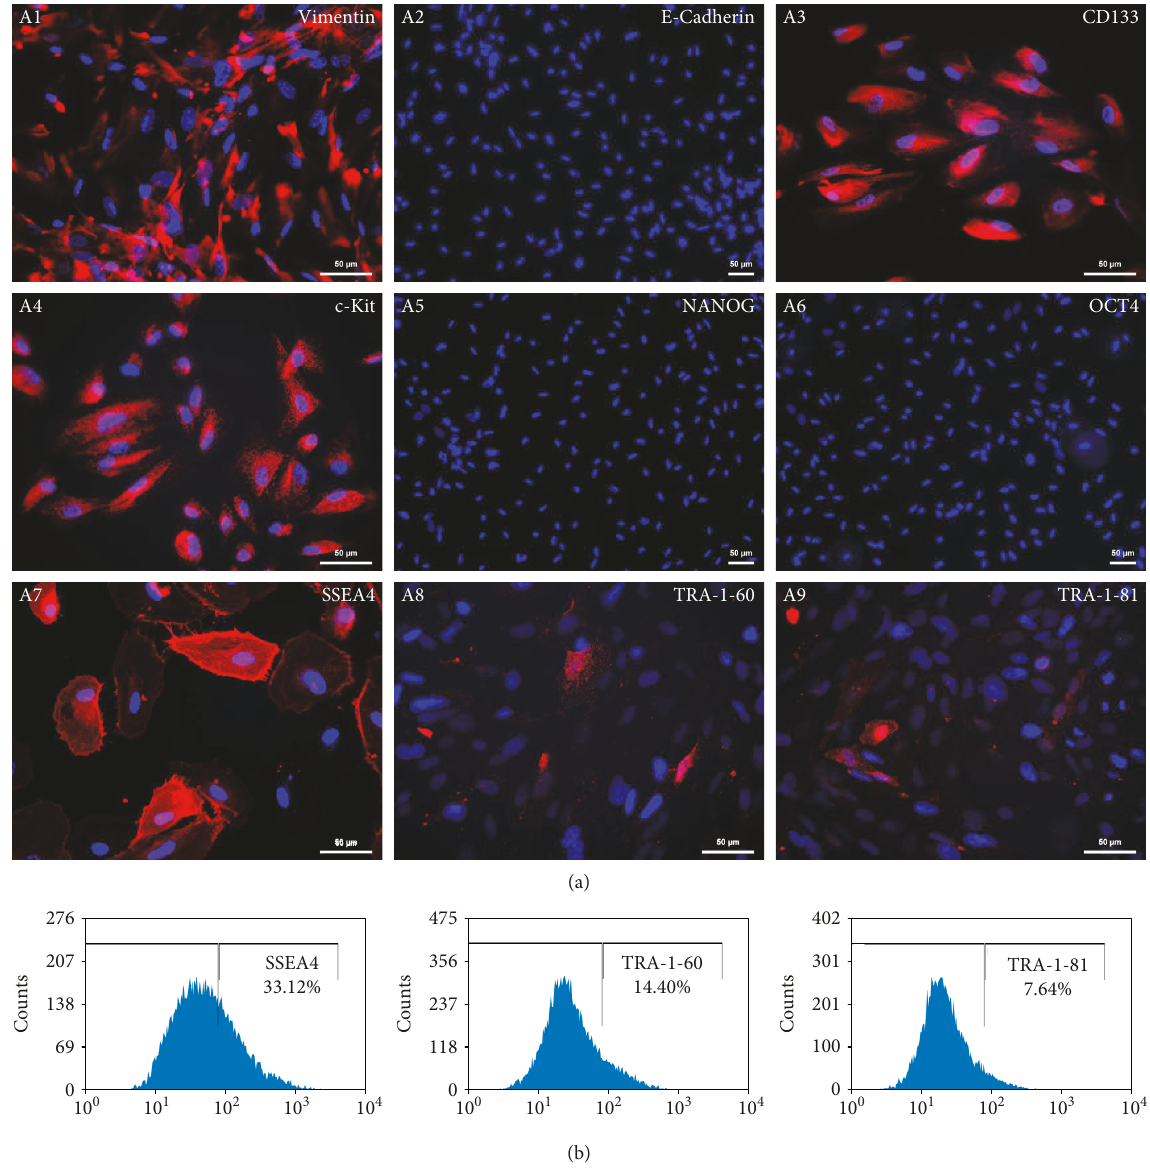
Figure 3: Protein expression analysis of AF-MSCs . (a) By immuno fl uorescent staining, AF-MSCs were found to express vimentin (A1), CD133 (A3), c-Kit (A4), SSEA4 (A7), TRA-1-60 (A8), and TRA-1-81 (A9) and by parallel absence of E-cadherin (A2), NANOG (A5), and OCT4 (A6). Cell nuclei were stained using Hoechst. (b) Flow cytometric analysis con fi rmed cell surface expression of SSEA4 (B1), TRA 1-60 (B2), and TRA-1-81